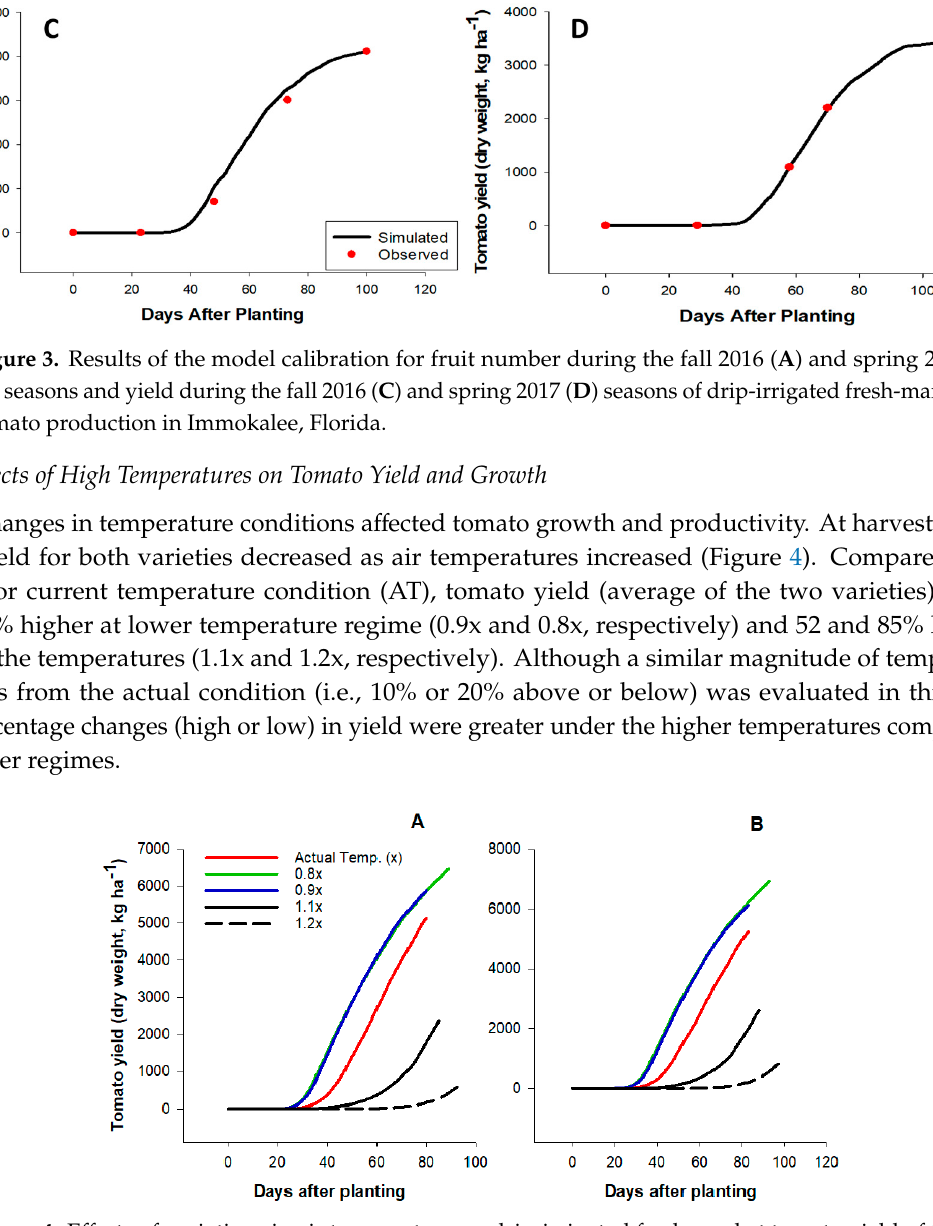
105 Table 4. Root ‐ mean ‐ square error (RMSE) and Willmott d index ( d ‐ Stat) for biomass production, fruit weight, and fruit number after calibration. Season